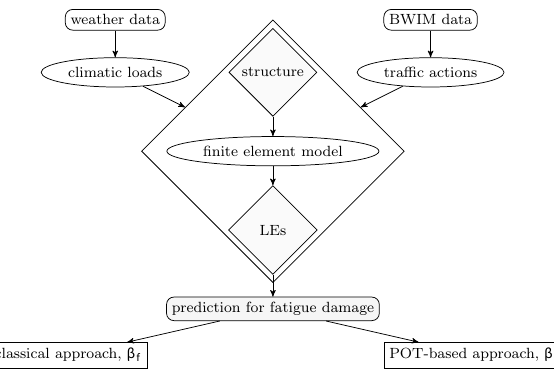
Fig. 1 General methodology, from monitoring to